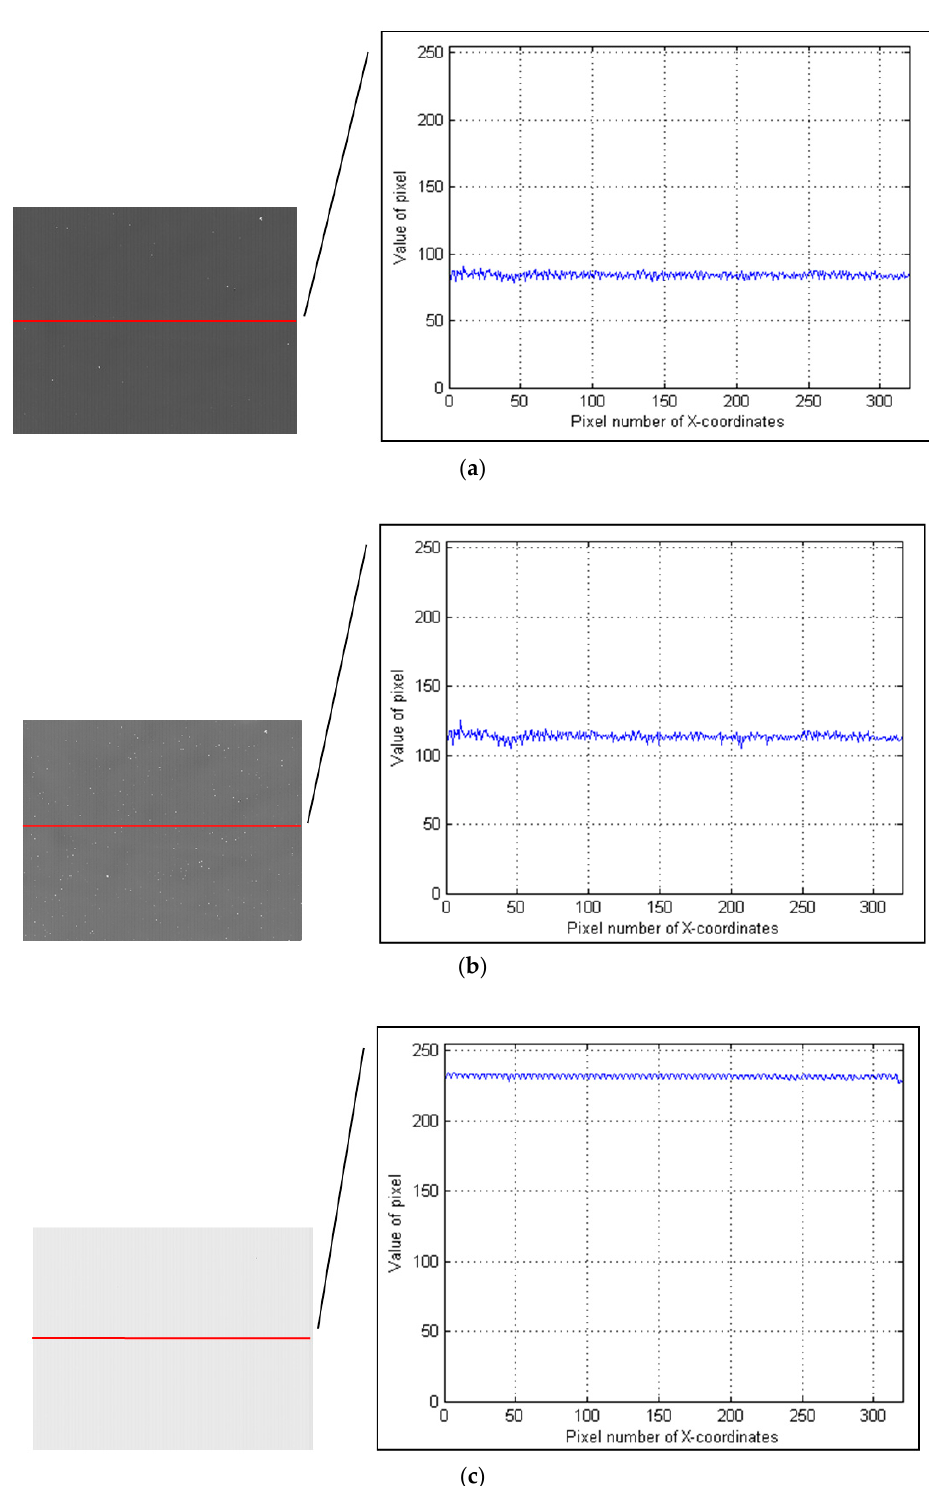
Figure 3. Spectral images acquired by the traditional SWIR AOTF imaging spectrometer (the detector is a non-deep cooling mercury cadmium telluride (MCT) focal plane array (FPA)). The curve on the right is the row of data contained in the red line on the left. The data here are the results of 8-bit quantization and 255 is the max number of pixels. The integration times of images ( a – c ) are 5, 10, and 20 ms, respectively. The target object is a checkerboard, but the signals will be submerged by a dark current no matter which integration time is